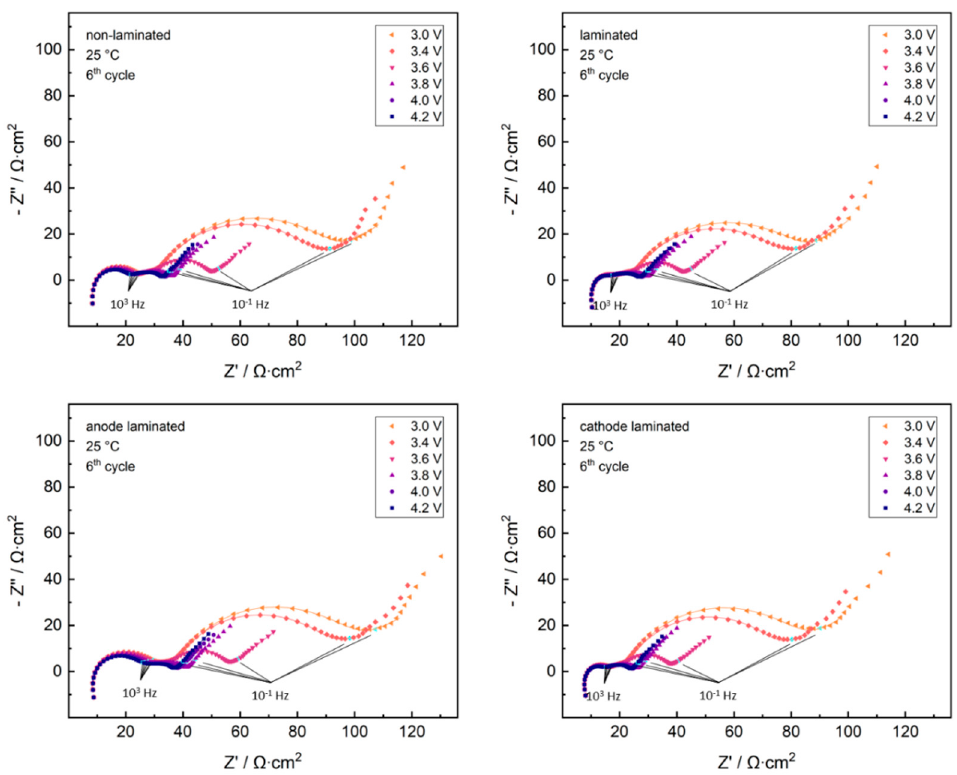
Figure 1. Impedance measurements of laminated/partially laminated/non-laminated cells: EIS (100 kHz – 10 mHz) along charging step, 6th cycle; fitting curves indicated as solid lines; data points at 10 3 Hz and 10 − 1 Hz highlighted in pale blue.